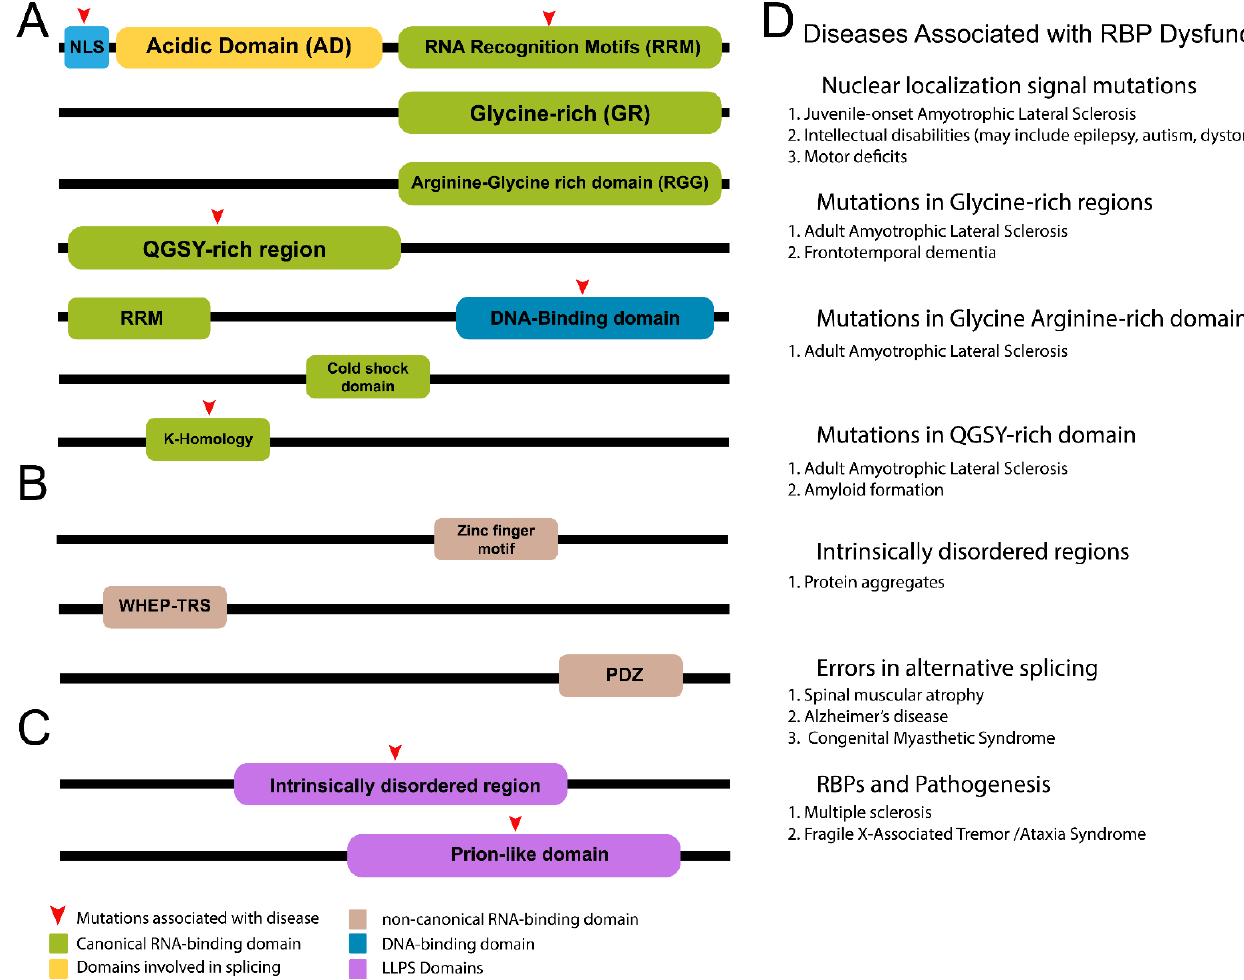
Figure 2. Structural Properties of RNA ‐ binding proteins. Illustration depicts common RBP domains.